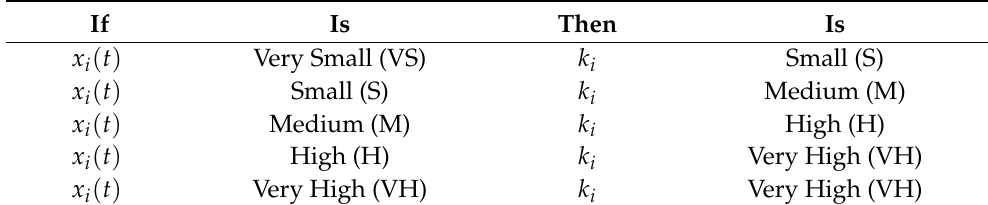
Table 2. Fuzzy rules for each area.